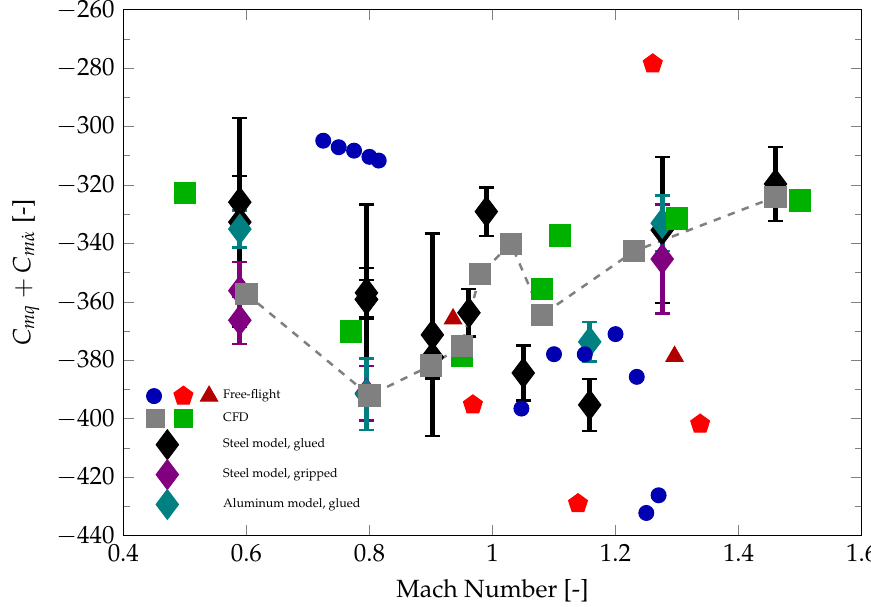
Figure 11. C mq + C m ˙ α over Mach number for the Basic Finner model – transonic range.